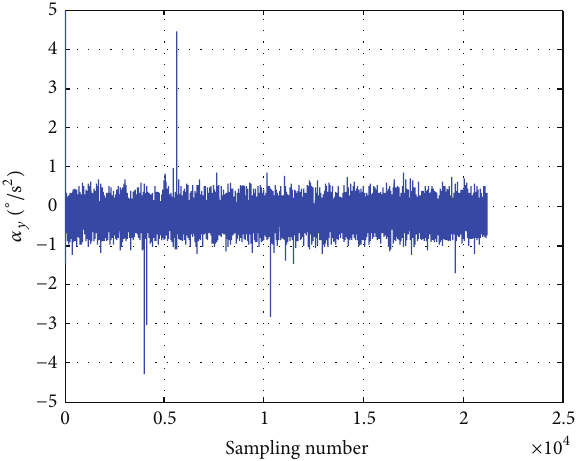
Figure 16: 𝛼 𝑦 for uncontrolled system.